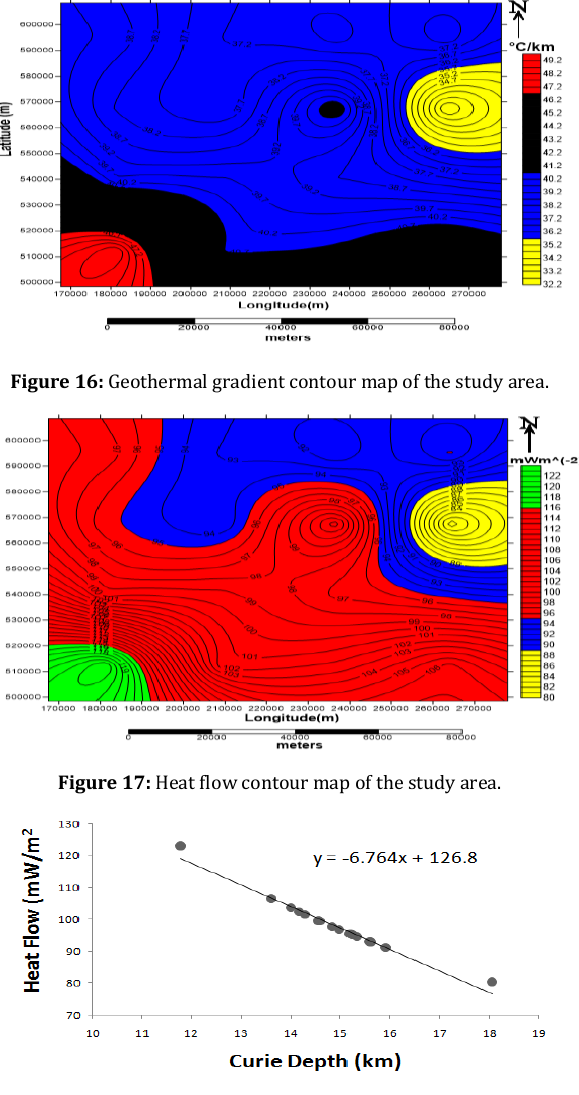
Figure 18: Plot of heat flow against Curie point